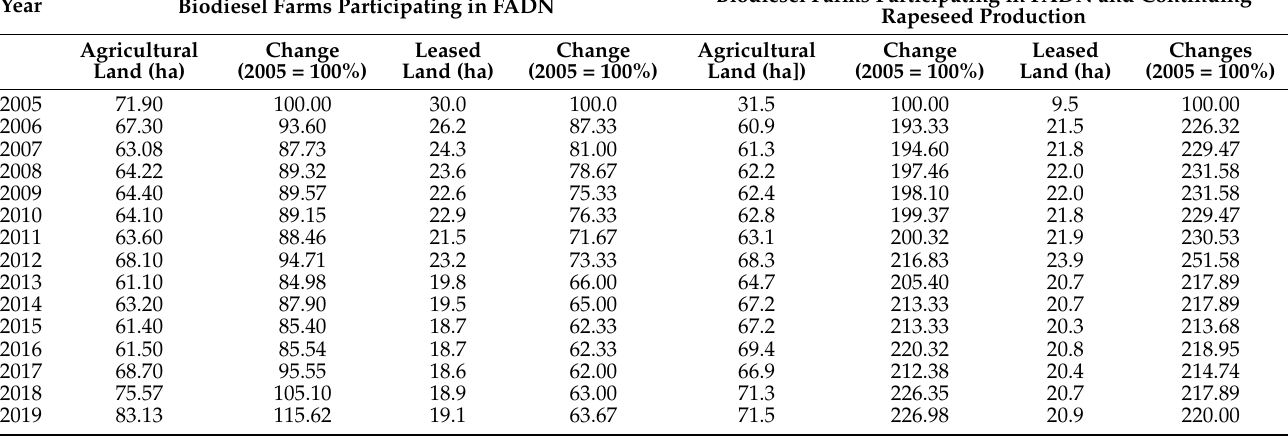
Table 3. Agricultural land (ha) and fixed-base indices of changes in agricultural area in biodiesel farms participating in the